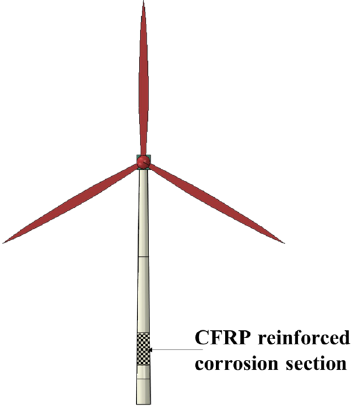
Figure 19. Wind turbine tower strengthened with CFRP. Table 6. CFRP material parameters.